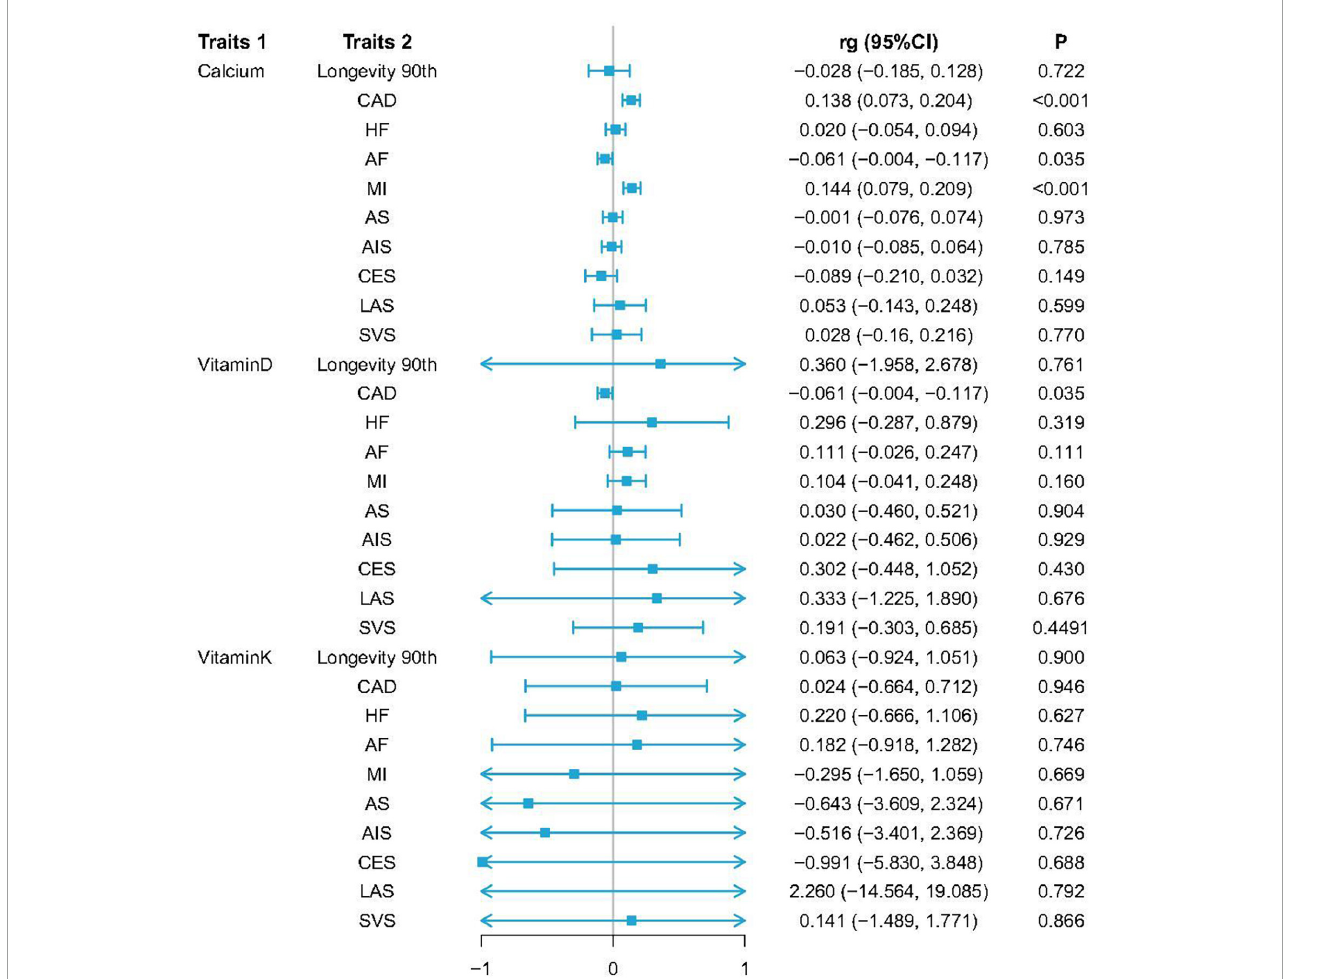
FIGURE1 Genetic correlation estimates for the associations between serum levels of calcium (Ca), vitamin D (VD), and vitamin K1 (VK1), and cardiovascular diseases (CVDs) as well as longevity. Traits 1 and 2 respectively, correspond to study exposures and outcomes. Error bars denote 95% confidence interval (CIs).